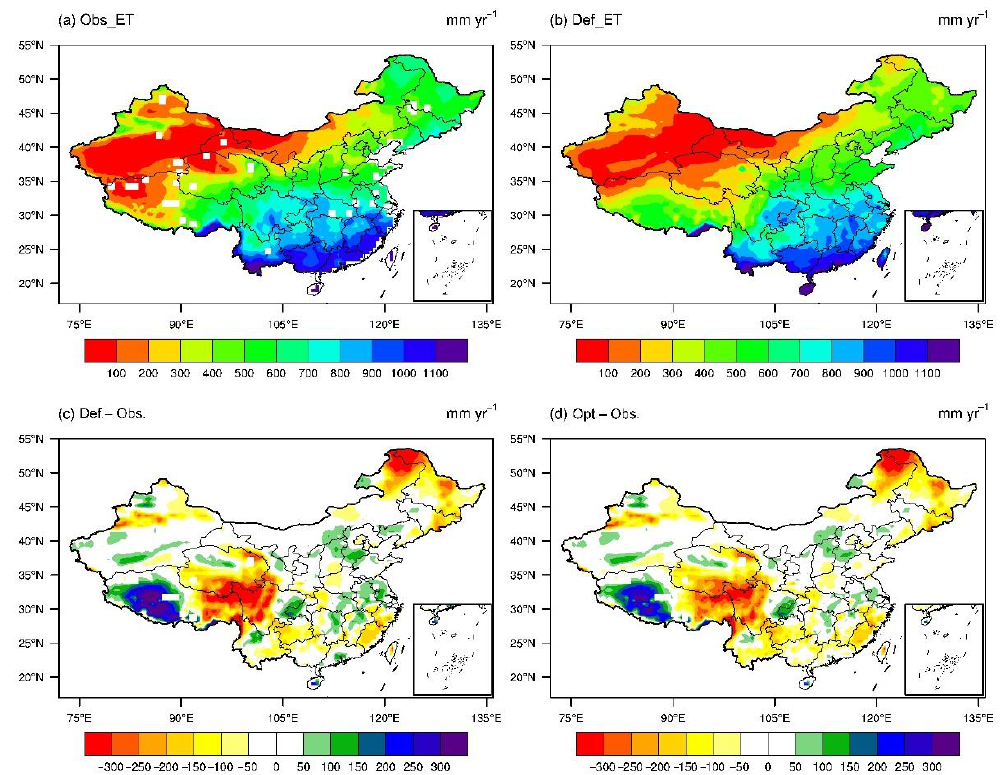
Figure 9. Comparisons of the spatial distribution of evapotranspiration simulations from 2014 to 2015 over China using Community Land Model version 4.0 model with default and optimal parameters: ( a ) observations. The white grids in China represent the missing values, ( b ) default simulations, ( c ) bias of default simulations minus observations, and ( d ) bias of optimal simulations minus observations.